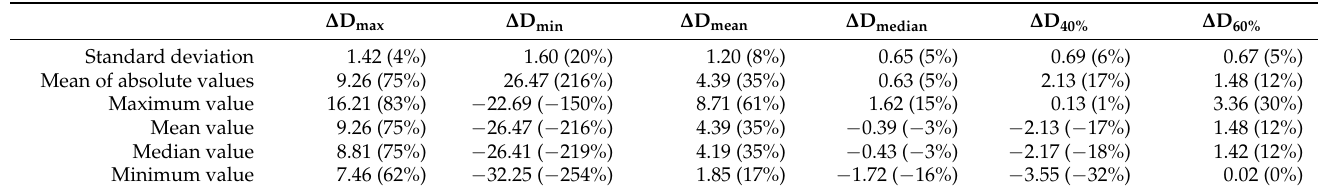
Table 7. The landslide thickness of the prediction minus the observation for 79 occurrence-time- unknown cases. (Unit: m, % relative to the